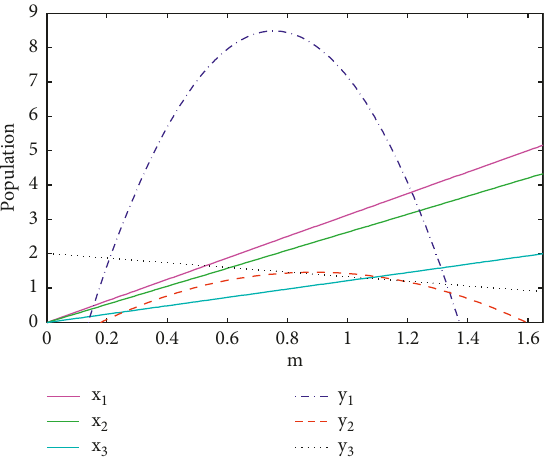
Figure 10: Effect of m on all the species.